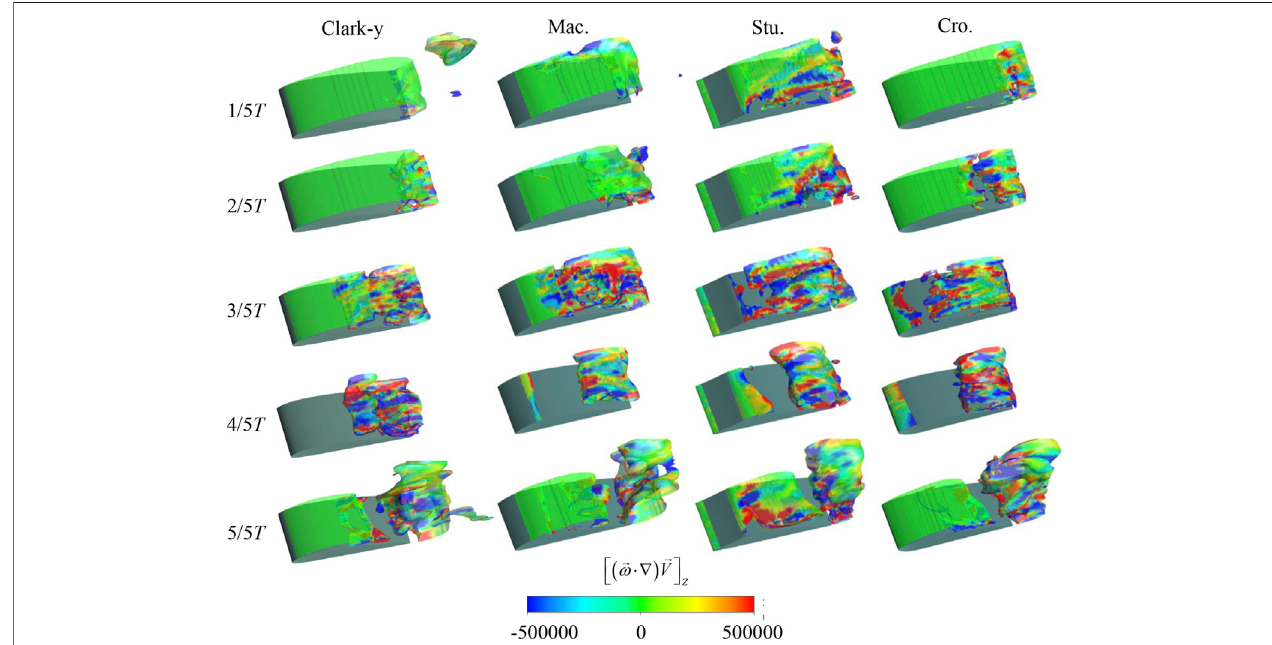
FIGURE 11 | Comparison of the Z-direction vortex-stretching term evolution of the four hydrofoils in a typical cycle.